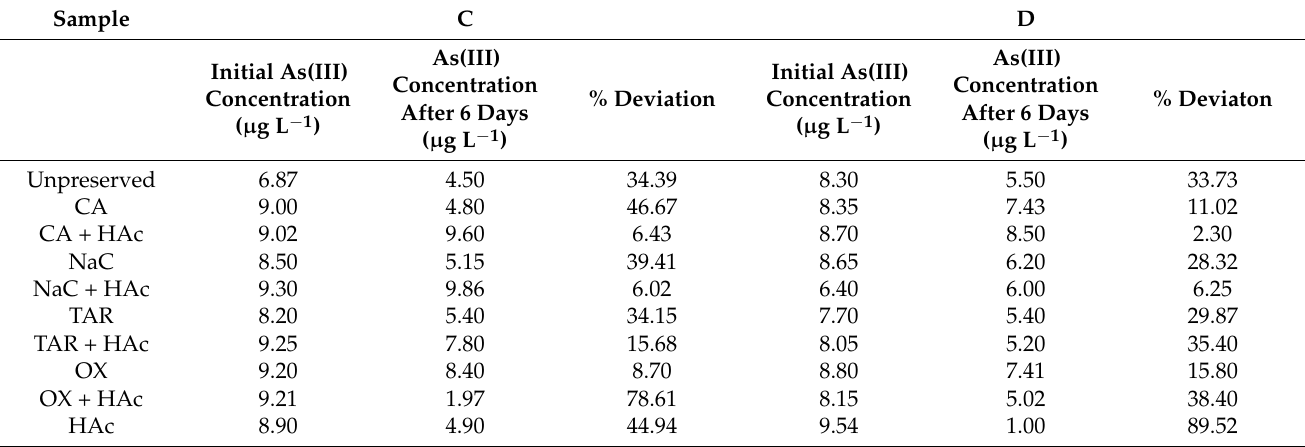
Table 4. Summary of the results for arsenic preservation, using nine preservatives in natural groundwater samples C and D, in the presence of